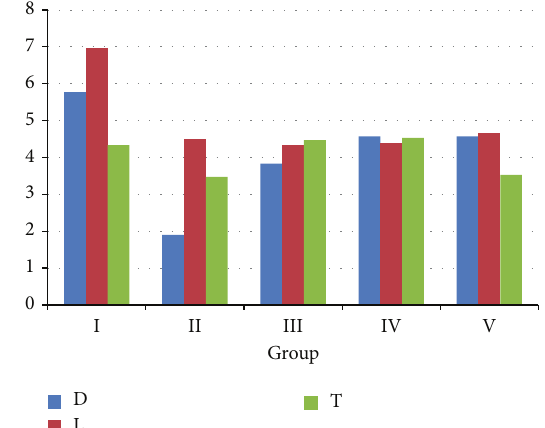
Figure 2: Comparison between the studied groups according to /d/l/t sounds measured by time interval